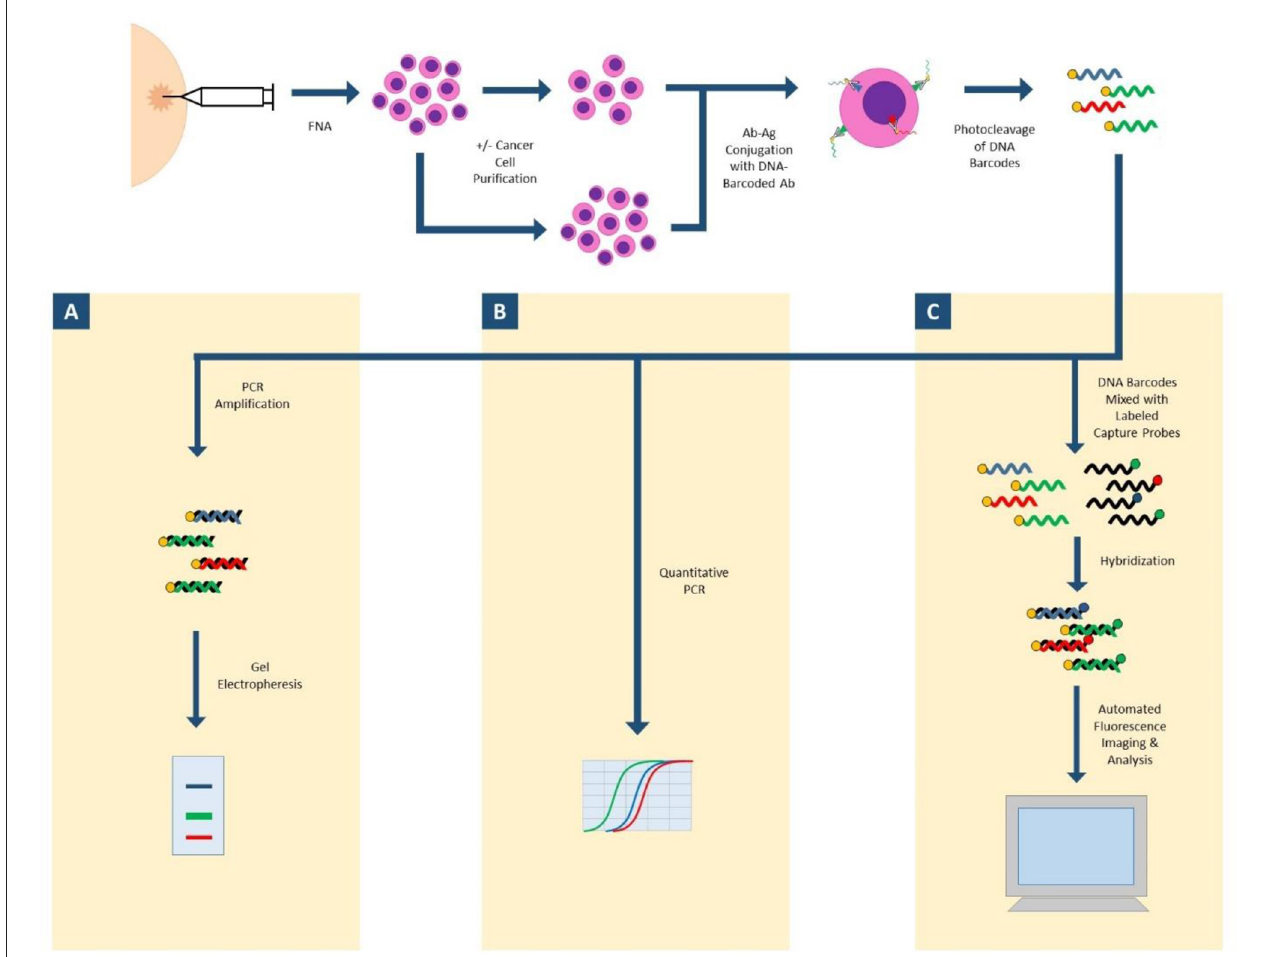
FIGURE 1 | ABCD (antibody barcoding with cleavable DNA). FNA biopsy is performed to isolate cells of interest, which may undergo a purification step. Cells are incubated with DNA-barcoded antibodies to proteins of interest. DNA barcodes are cleaved from antibodies. (A) Released DNA-barcodes can undergo PCR amplification and gel electrophoresis for semi-quantitative measurement of protein expression; (B) Released DNA-barcodes can undergo multiplex quantitative PCR; (C) Released DNA-barcodes can be hybridized with fluorescent labeled capture probes and automatically imaged and analyzed with nanostring